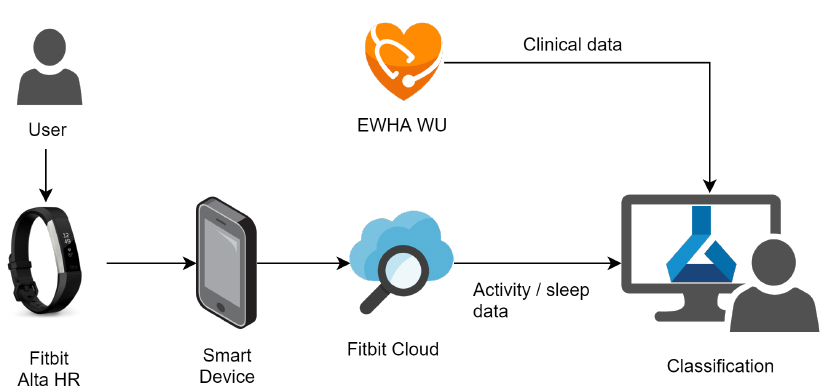
Figure 1. Data acquisition and analysis